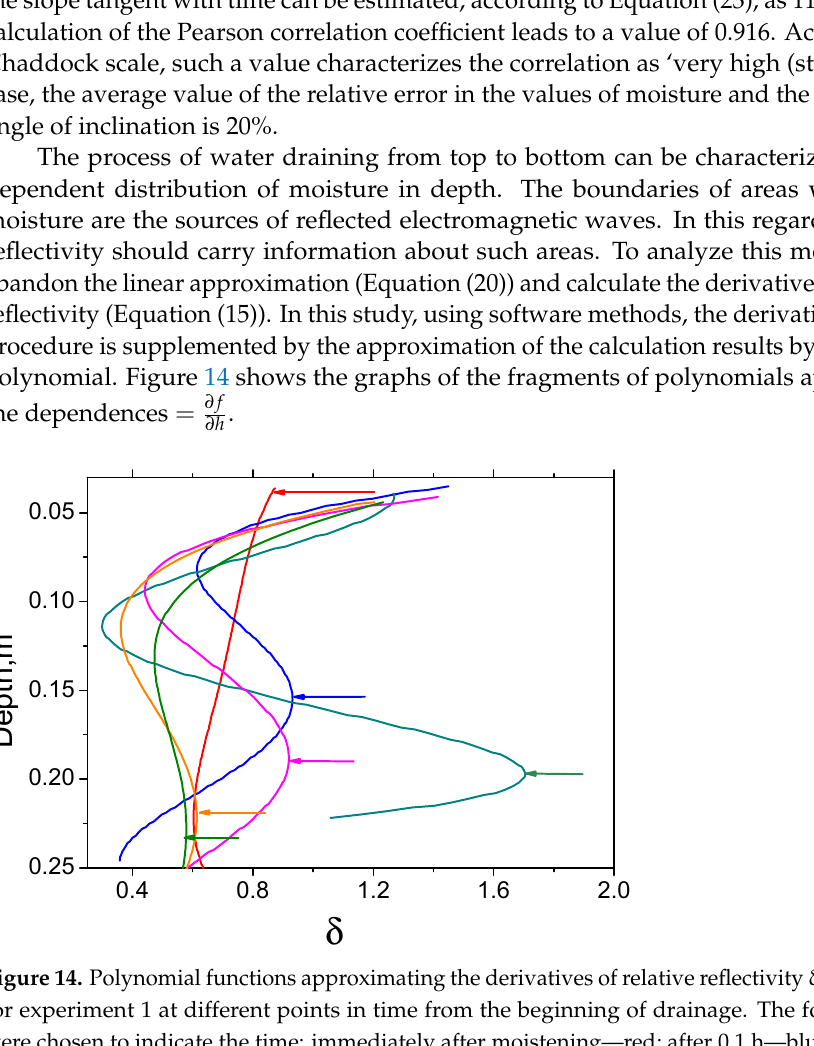
Figure 13. Dependence of moisture (W , %—red circles ● ) and tangent of the slope angle of the rela-